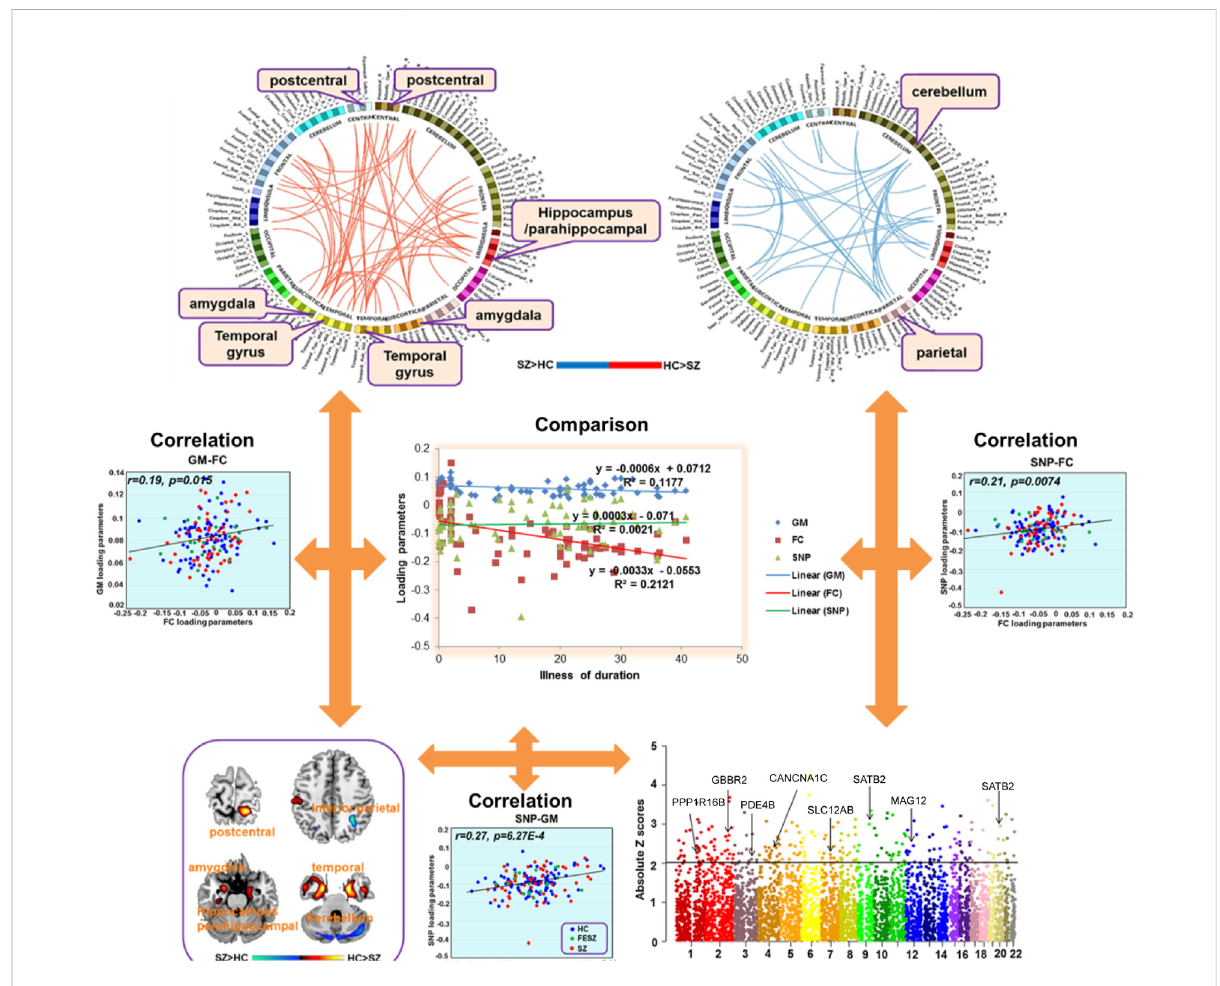
FIGURE 2 Relationships of SNP to GMV and FC alterations throughout the brain.